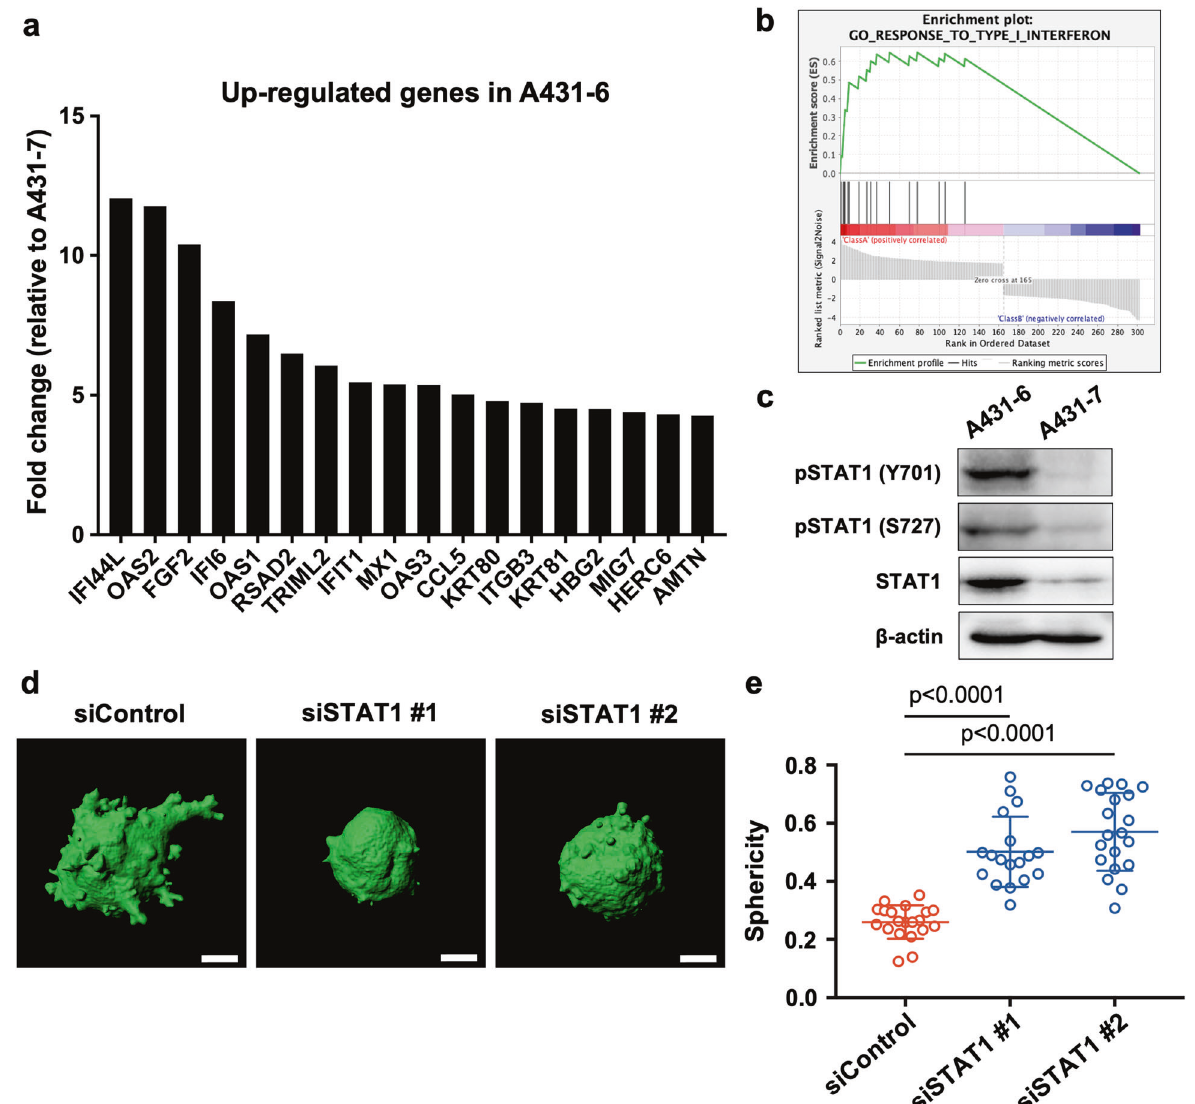
Fig. 2 STAT1 plays a crucial role in collective invasion of high-invasive A431-6 cells. a The DNA microarray result comparing the A431-6 and A431-7 subclones. Genes with more than a 4-fold increase in A431-6 are shown. b GSEA showing increased response to type-I interferon in A431-6 cells. c Representative western blotting images for pSTAT1 (Y701), pSTAT1 (S727), STAT1, and β -actin in A431-6 and A431-7 cells. This experiment was repeated three times, and similar results were obtained in all experiments. d Representative three-dimensional constructed images of siControl-, siSTAT1 #1- or STAT1 #2-treated A431-6 cell clusters cultured in a three-dimensional collagen gel culture system. The sphericity of siControl: 0.263, siSTAT1#1: 0.638, and siSTAT1#2: 0.633. Scale bars represent 30 µm. e Quanti fi cation of sphericity in ( d ). Lines show the mean with SD for n = 20 (siControl), n = 18 (siSTAT1#1), and n = 20 (siSTAT1#2) clusters by two independent